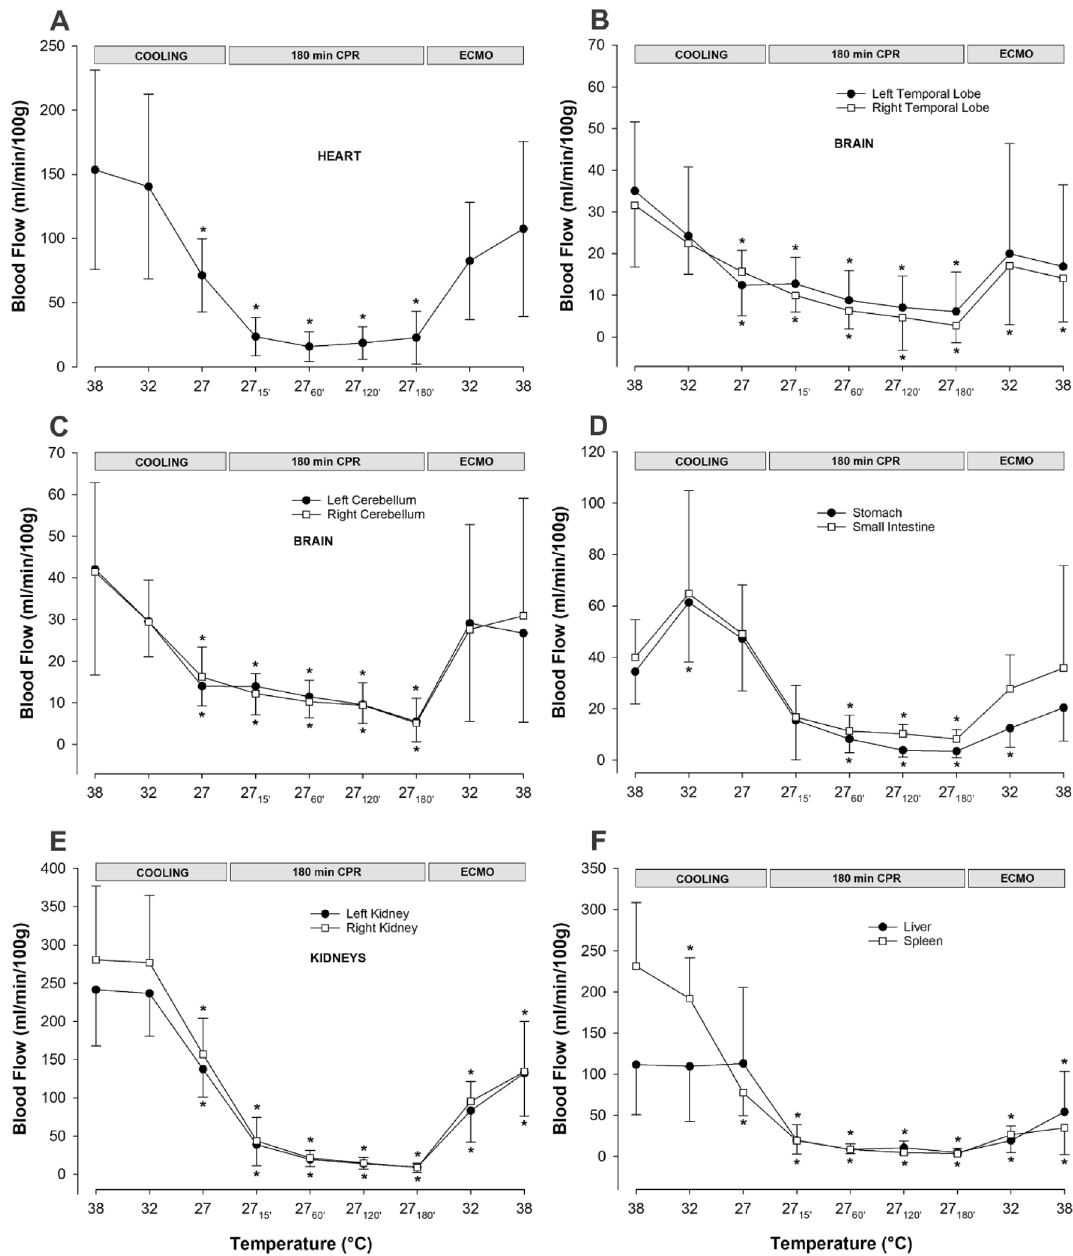
Figure 3. Regional blood flow during cooling, 3-h CPR at 27 °C, and ECMO rewarming. ( A ) Myocardial blood flow. ( B ) Blood flow in left and right temporal lobes. ( C ) Blood flow in left and right cerebellar hemispheres. ( D ) Blood flow in stomach and small intestine. ( E ) Renal blood flow. ( F ) Blood flow in liver and spleen. n = 8, values are mean ± SD. * p < 0.05 statistically significantly different from baseline